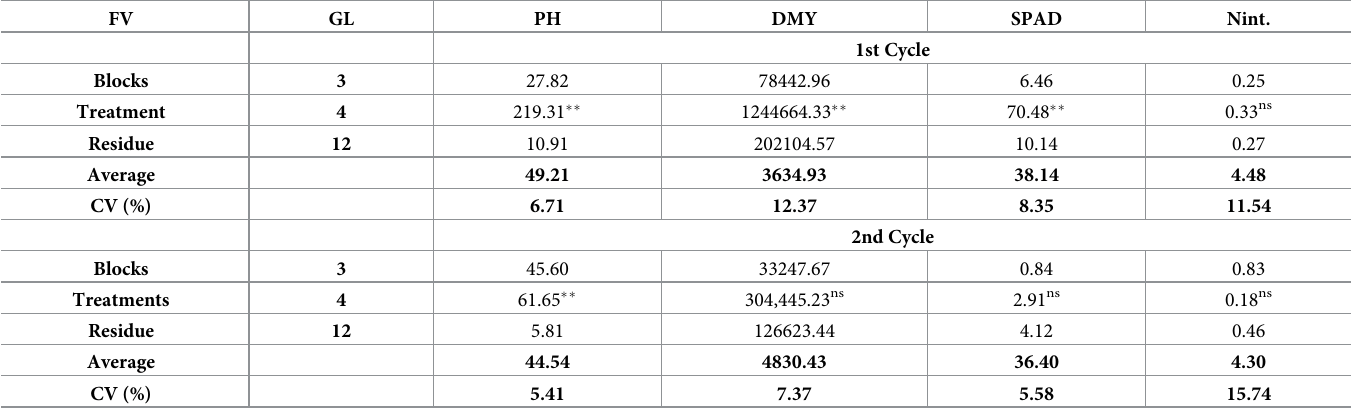
Table 7. Summary of the analysis of variance for the parameters accumulation of yield and vegetative development of the Tifton 85 bermudagrass in the first and second cropping cycles. FV